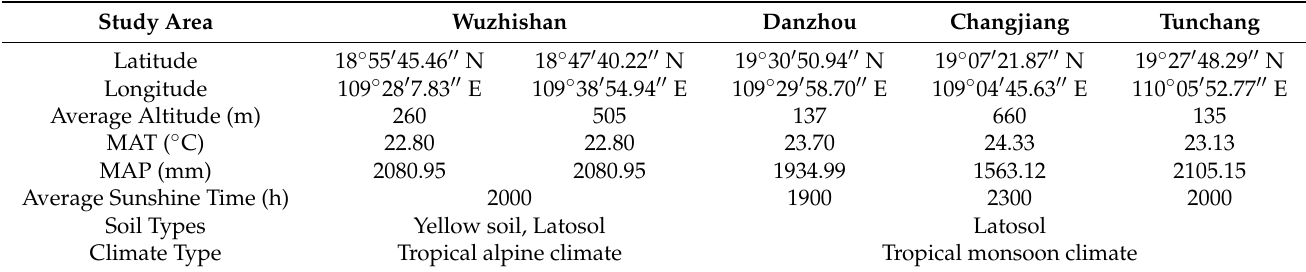
Table 1. Overview of the study area.